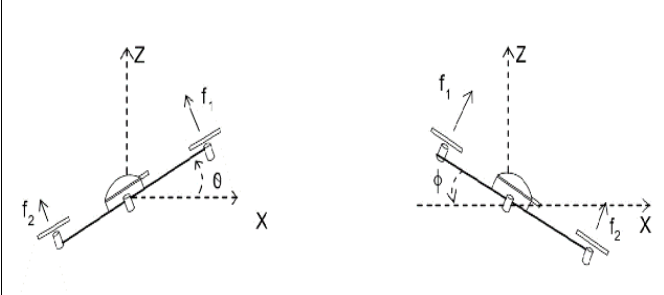
Figure 2: Schematic diagram of